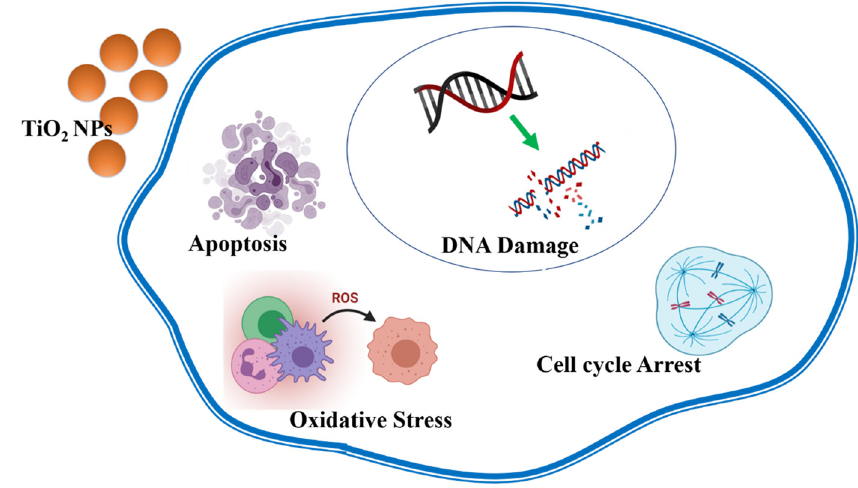
Figure 7: Illustration of anticancer mechanistic events of TiO 2 - NPs against cancer